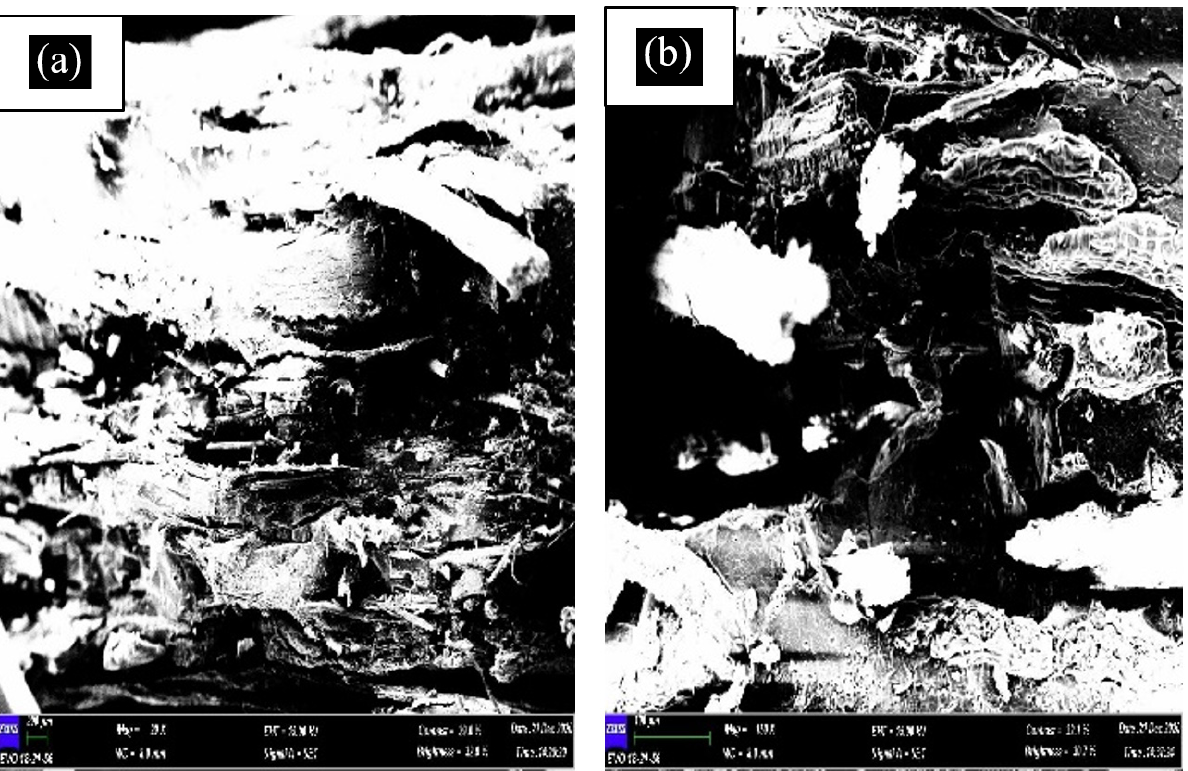
Figure 12. SEM micrograph of TPCS + 30 wt.% banana leaf fibre; ( a ) the evidence of fibre break and ( b ) more void on fracture surface.